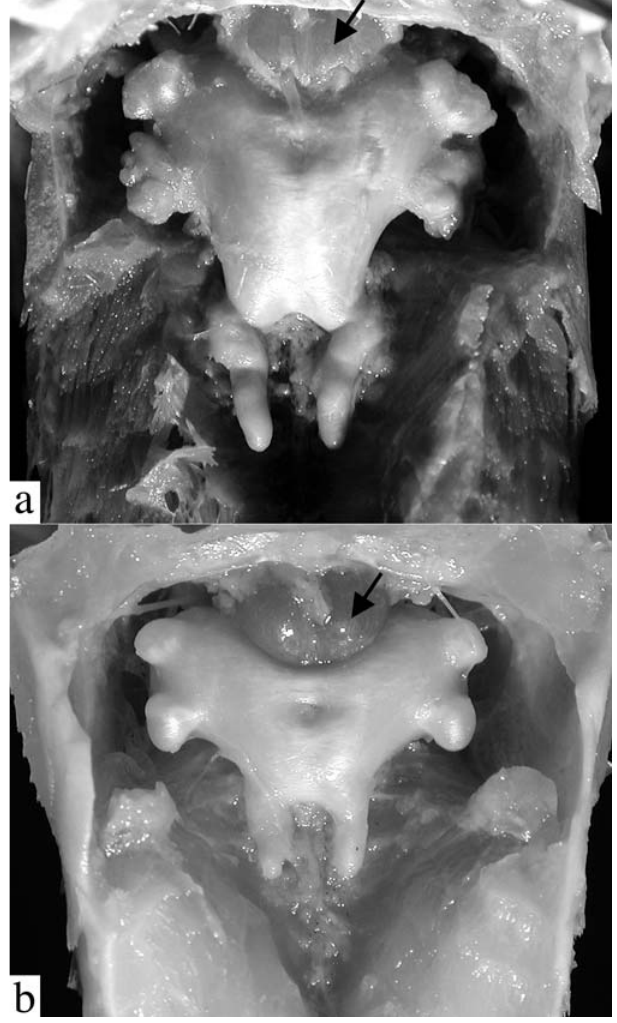
Fig. 7. Ventral views of gas bladders in situ (arrows denote bony capsules of enlarged first vertebra). a. Leptodoras praelongus , ANSP 162463 (SL 142 mm). b. Leptodoras cf. cataniai , Nanay form, INHS 39814 (SL 111.1